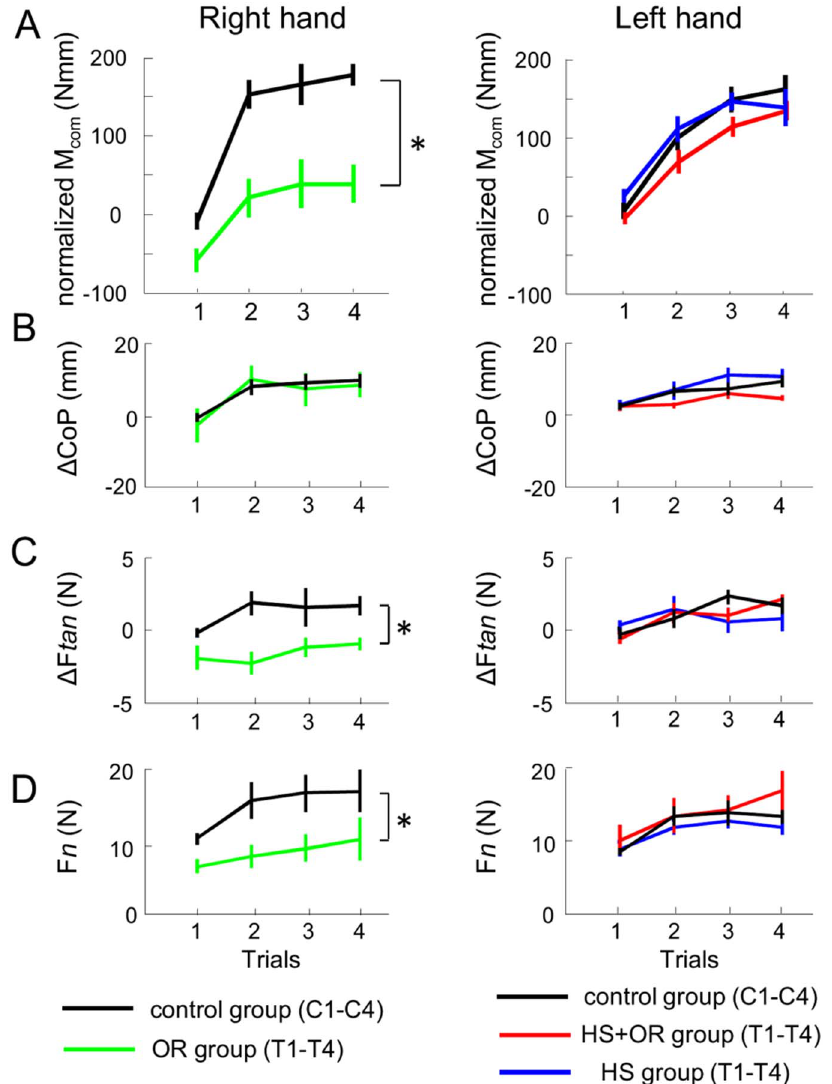
Figure 4. Task-related variables as a function of exposure to transfer trials. Data from the OR group (green) and right hand control (black) are shown on the left, whereas data from the HS group (blue), HS + OR groups (red), and left hand control (black) are shown on the right. Data from transfer trials (T1–T4) are from the transfer groups, whereas data from regular trials (C1–C4) are from the control groups. Panels A, B, C, and D show normalized compensatory moment (M com ), digit placement ( D CoP), digit load force sharing ( D F tan ), and grip force (F n ), respectively. The asterisks denote significant differences ( p , 0.05). Data are averages of all subjects and vertical bars denote standard errors of the mean.